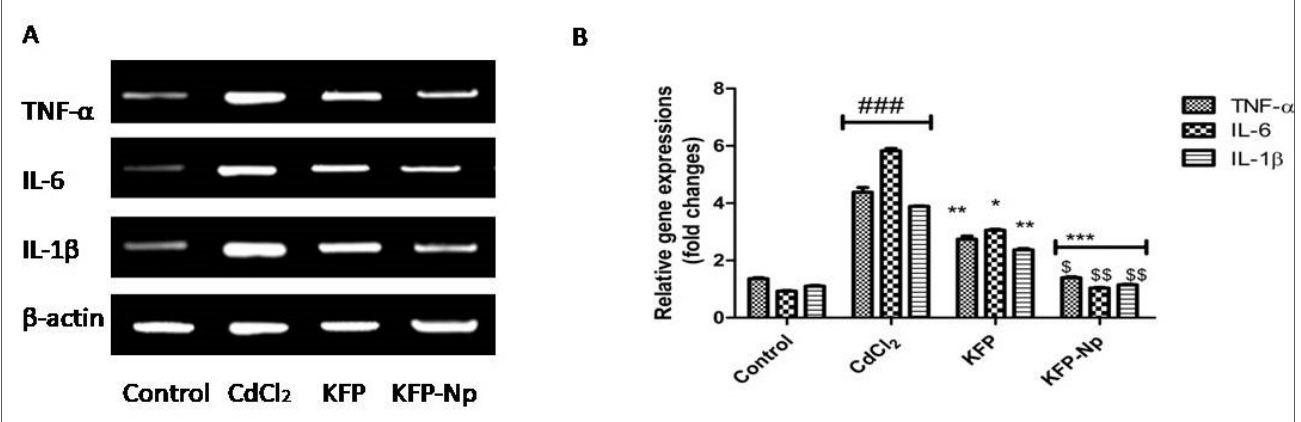
Figure 8. The effects of KFP-Np on inflammation-related gene mRNA expression. Data are presented as mean ± SD in each group ( n = 10).The relative mRNA levels of TNF- α , IL-6 and IL-1 β in different groups were determined by RT-PCR and normalized to the β -actin ( A ). Fold changes of various gene expression in different groups ( B ). ### p < 0.001 significantly different from control group; * p < 0.05, ** p < 0.01 and *** p < 0.001, significantly different from the CdCl 2 group and $ p < 0.05 and $$ p < 0.01 significantly different from the KFP group.IL-6: interleukin 6; TNF- α : tumor necrosis factor- α ; IL-1 β : interleukin 1 β .